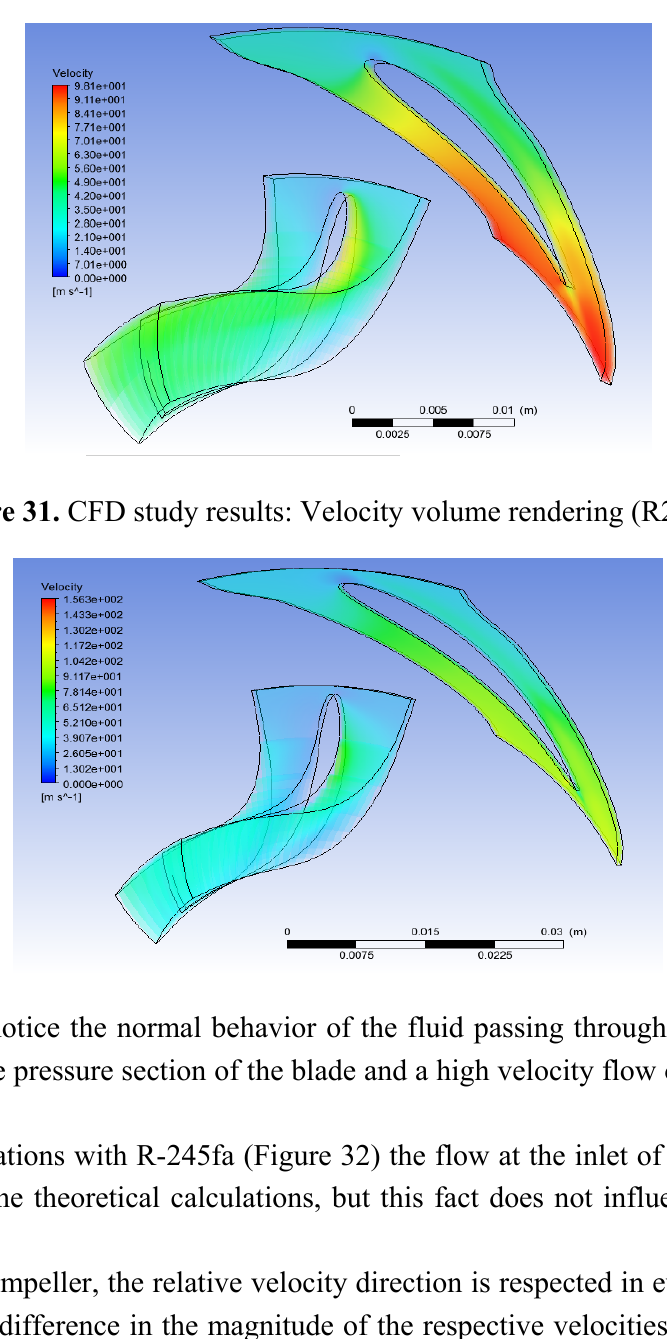
Figure 30. CFD study results: Velocity rendering volume rendering (R134).